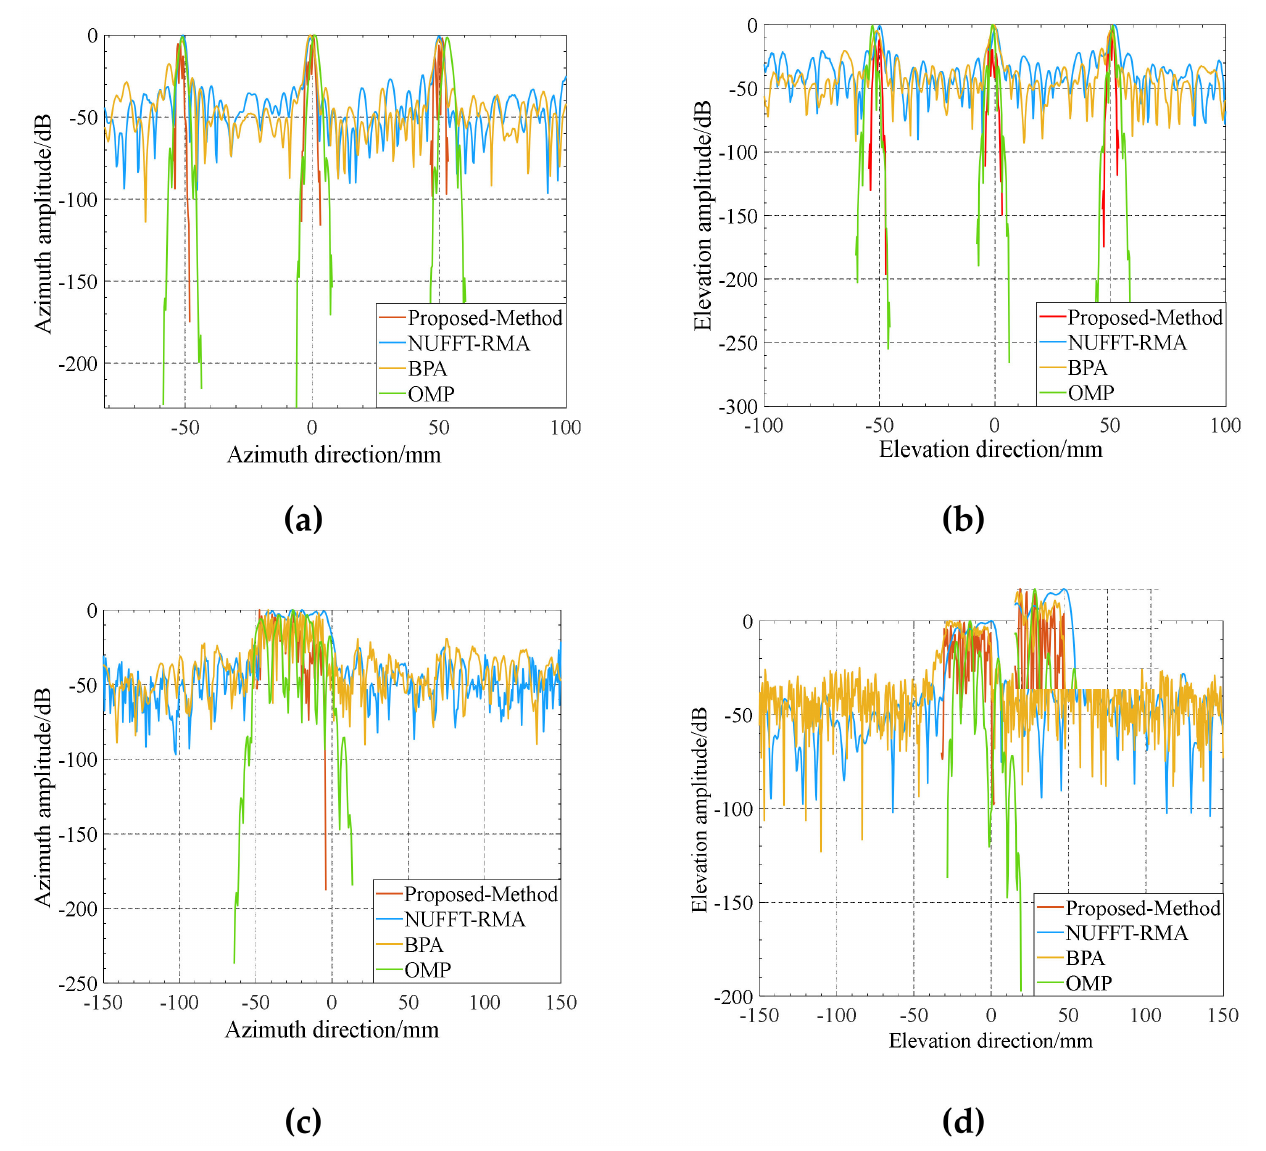
Figure 8. Azimuthal and elevation profiles. ( a ) The azimuthal profiles of the multiple targets. ( b ) The elevation profiles of the multiple targets. ( c ) The azimuthal profile of the wrench. ( d ) The elevation profile of the wrench. Table 3. The mean difference of principal